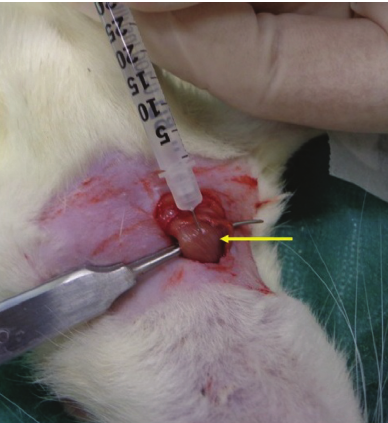
Figure 1: Exposure of right sternocleidomastoid muscle (yellow arrow) and direct intramuscular injection of substance.